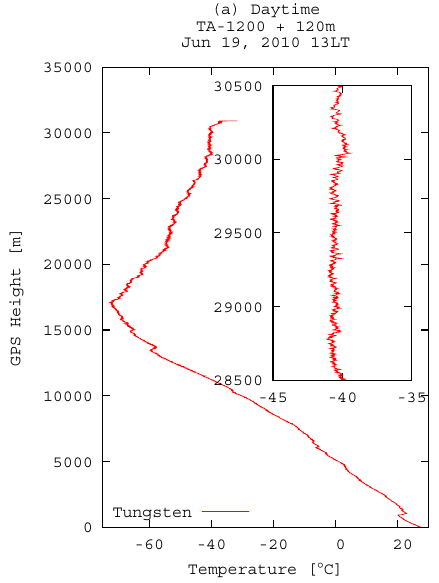
Fig. 11. The same as Fig. 8 (left) but for those taken from the sound- ing on 19 June 2010 made by using the suspension line of 120m. In this case, the use of a long suspension line reduces the swing angle to about 10 ◦ , while the solar zenith angle is about 42 ◦